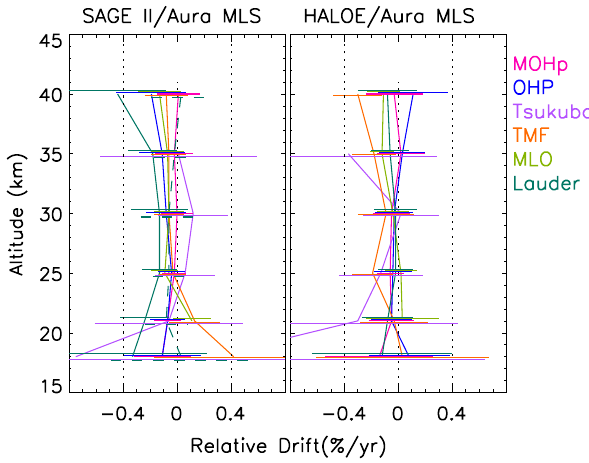
Fig. 10. The drifts evaluated from the combined time series of SAGE II with Aura MLS (left) and HALOE with Aura MLS (right) at various stations. The dashed green line in the left panel represents the drift of SAGE II ⁄Aura MLS at Lauder estimated after removing the first two measurements. The error bars represent twice the stan- dard deviation of the slope. The dotted vertical lines represent 0 and ± 0.4%yr − 1